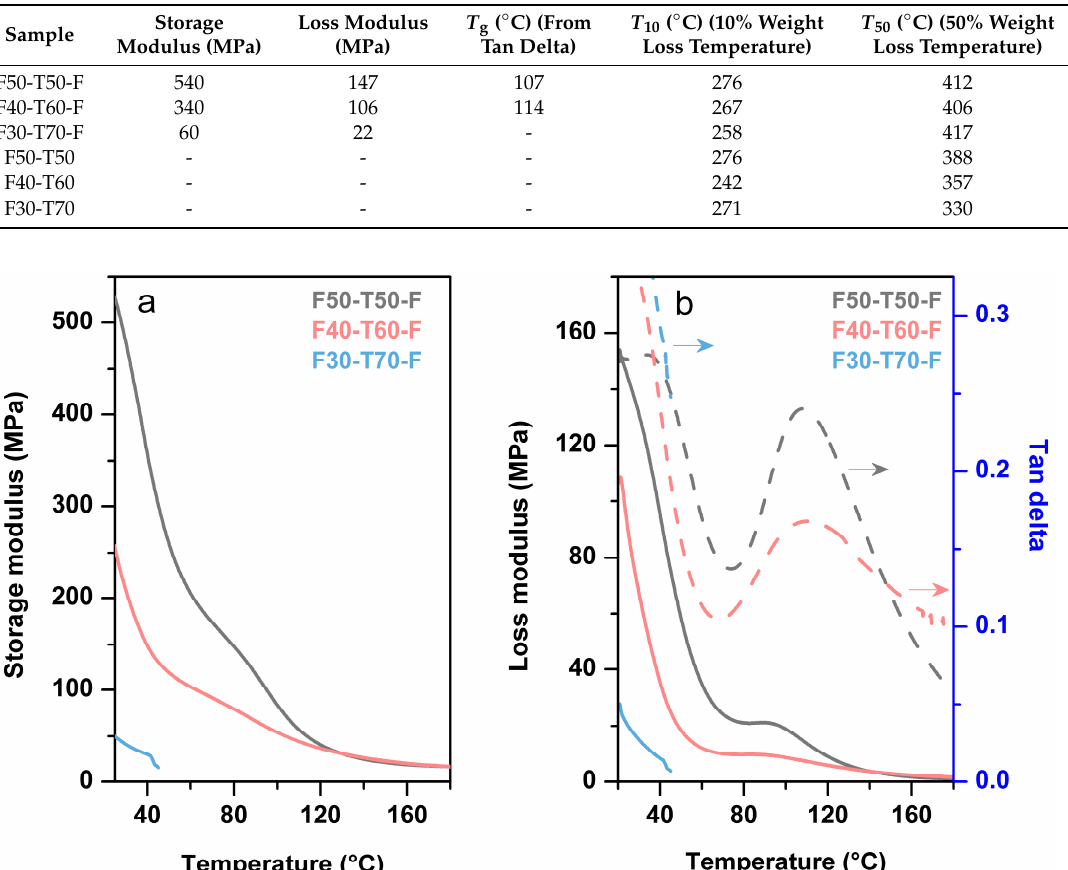
Table 2. Modulus values at room temperature and T g from DMA (dynamic mechanical analysis) and different weight loss temperatures from TGA (thermogravimetric analysis).